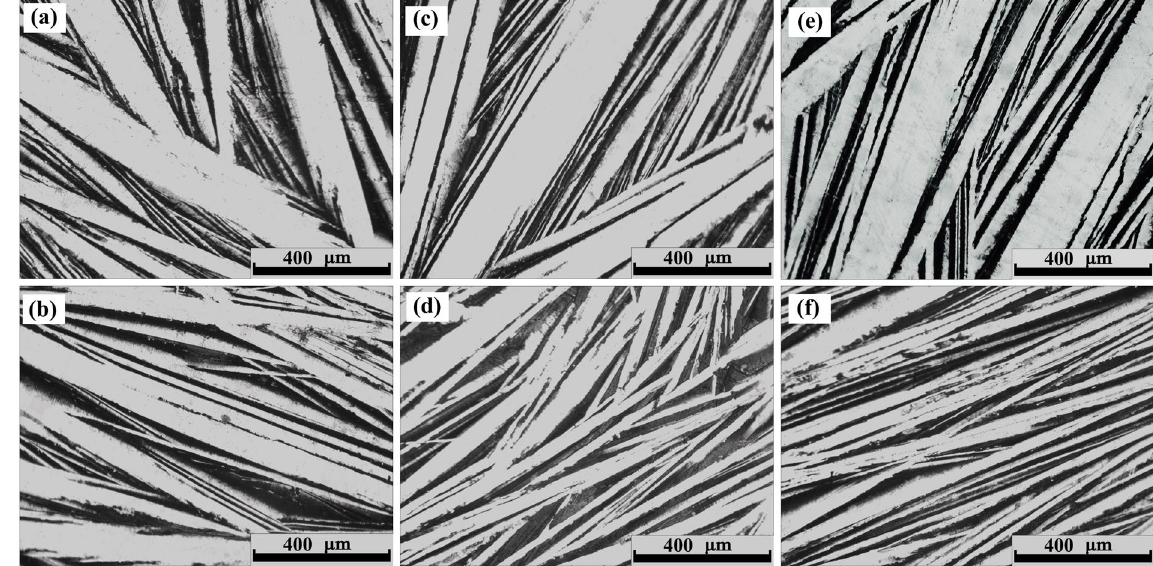
Figure 4. Solidification microstructures as observed by optical microscopy along the radial direction of the cylindrical ingot for both A-group (upper row) and B-group (lower row) samples. ( a ) Bi 2 Te 2.7 Se 0.3 -A; ( b ) Bi 2 Te 2.7 Se 0.3 -B; ( c ) Bi 2 Te 2.55 Se 0.45 -A; ( d ) Bi 2 Te 2.55 Se 0.45 -B; ( e ) Bi 2 Te 2.4 Se 0.6 -A; ( f ) Bi 2 Te 2.4 Se 0.6